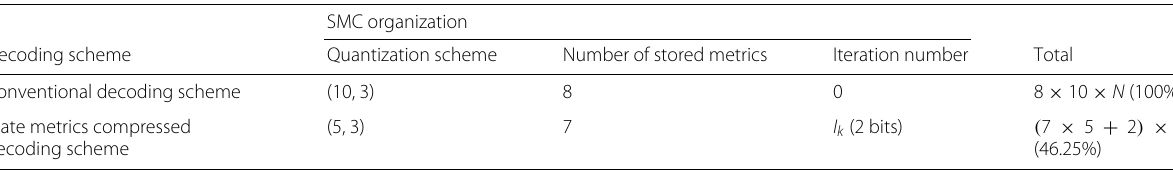
Table 1 Comparison of SMC organization and capacity